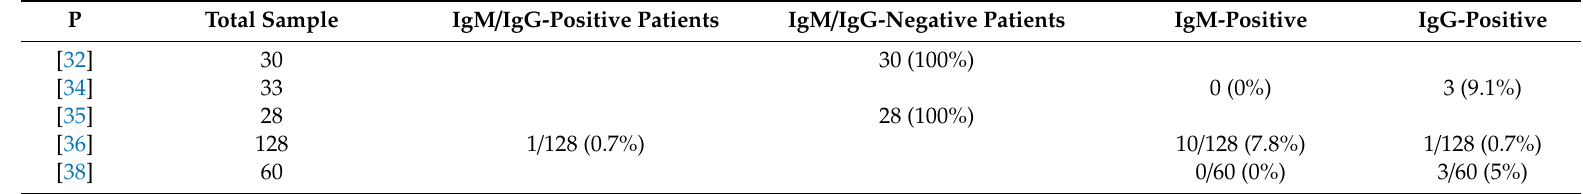
Table 5. Anti-SARS-CoV-2 IgM and IgG rates in negative